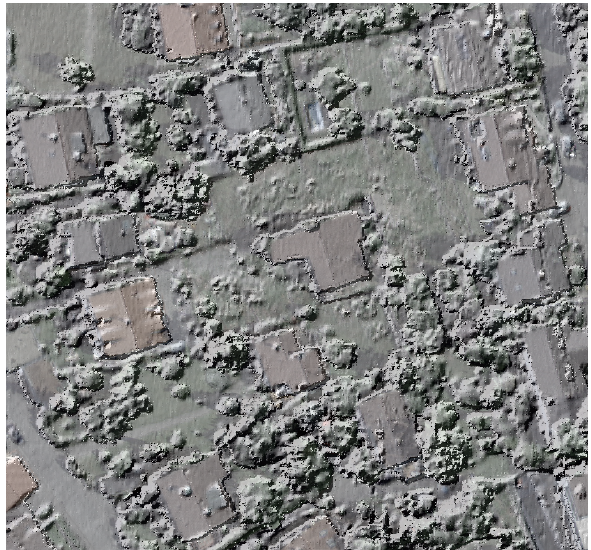
Figure 5: a sample of points originally classified as on buildings (magenta) vs. higher quality building outlines (cyan) found by image segmentation of unmasked regions.